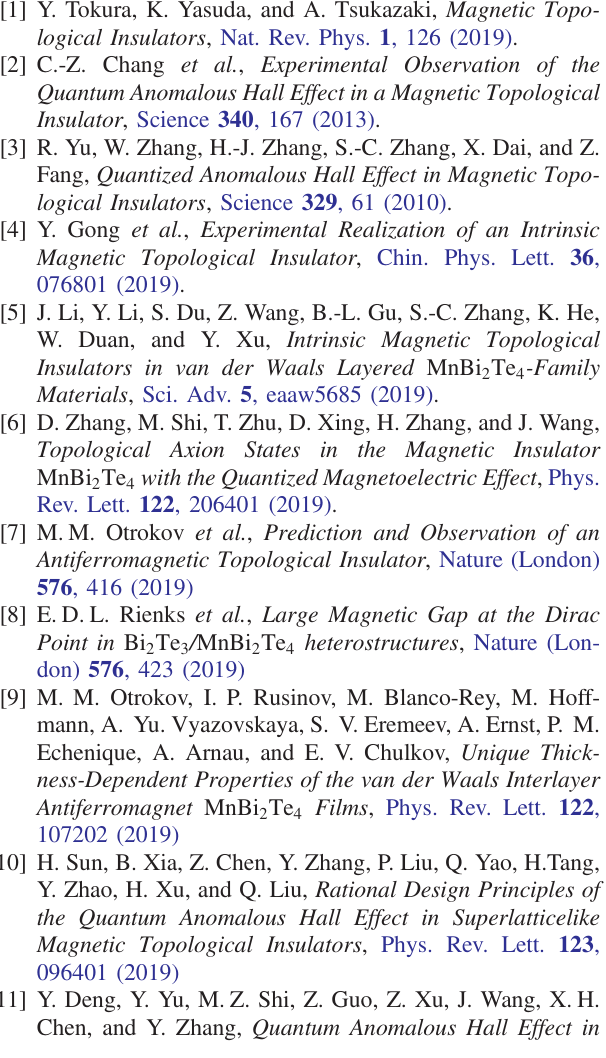
[Fig. 2(d)] is obtained at Beam line 9B of HiSOR, using a VLEED spin detector and 18 eV incident